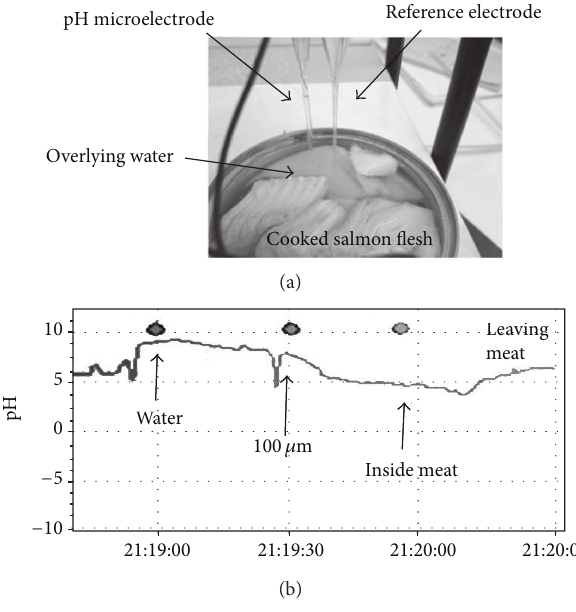
Figure 1: (a) Unisense pH microelectrode measurements per- formed in canned salmon samples; (b) there was a pH gradient from water overlying fluid towards the surface of the salmon meat. The gradient started at neutral pH 6-7 and ended at 4-5 inside the flesh.